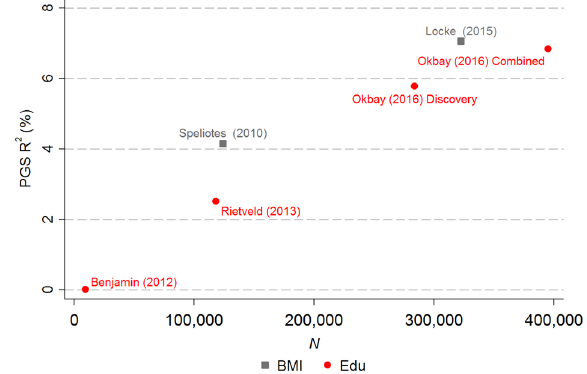
Fig. 2 Predictive power of PGSs derived from weights estimated in discovery samples of various sizes. All dependent variables have been residualized on sex, age, and 10 principal components of the variance – covariance matrix of the genotype data. To avoid over- fi tting, all scores are based on meta-analyses that omit the HRS from the discovery